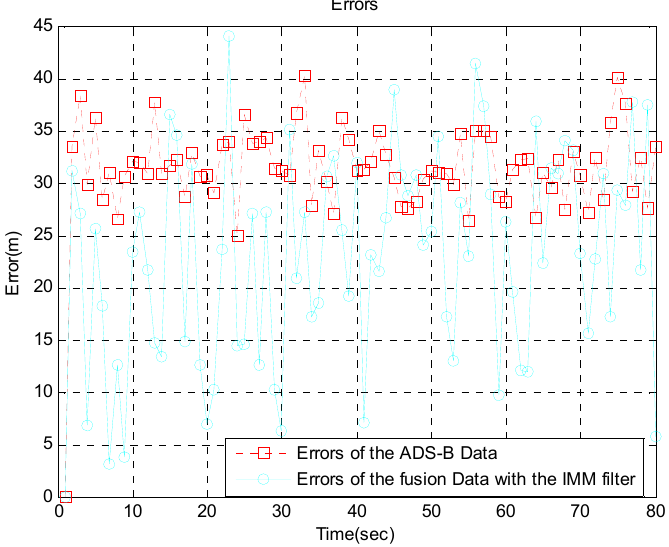
Figure 11. Errors between ADS-B data and fusion data with the IMM filter at 192 km from the airport.